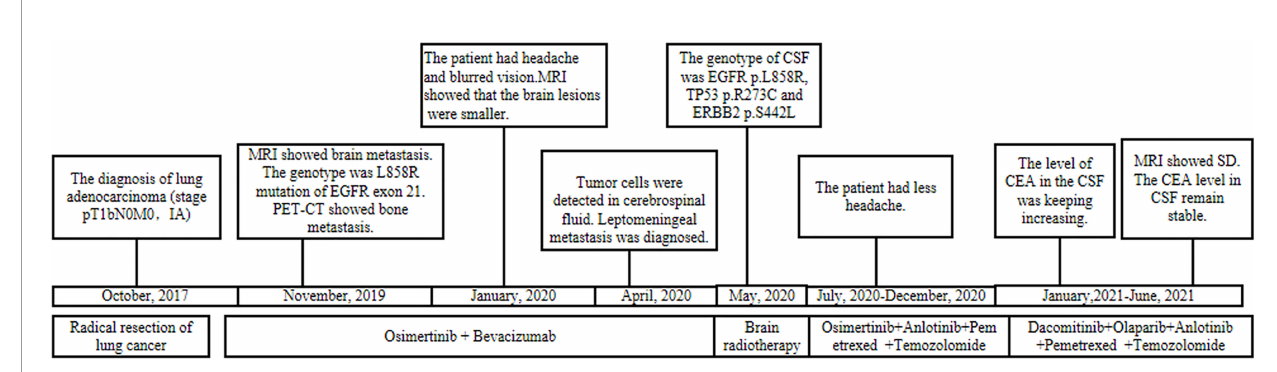
FIGURE 1 | Summary of the diagnosis and